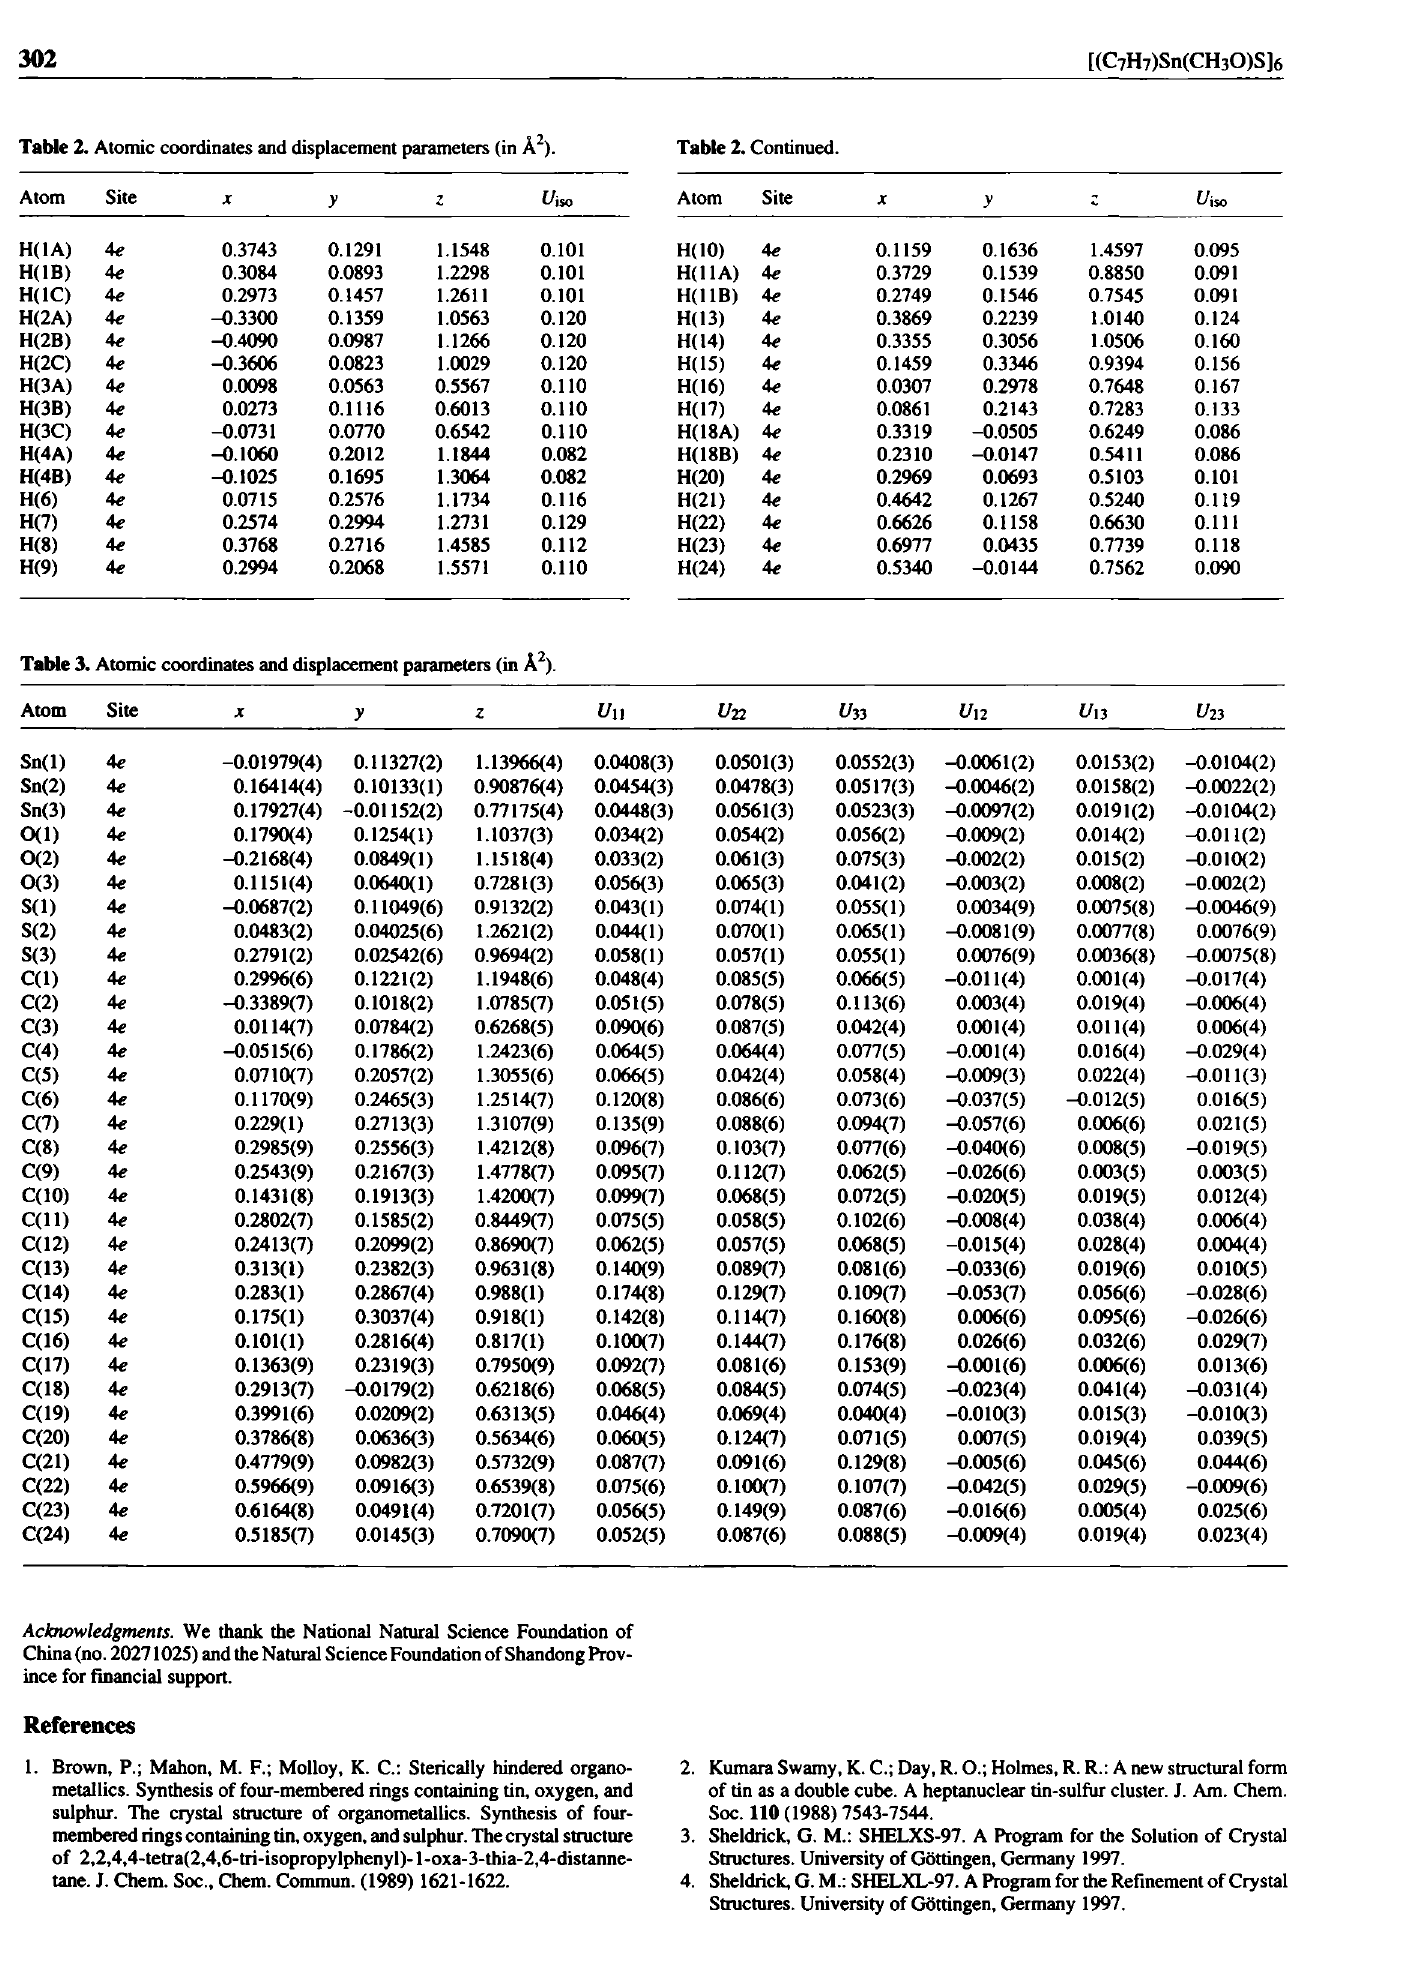
Table 3. Atomic coordinates and displacement parameters (in Â 2